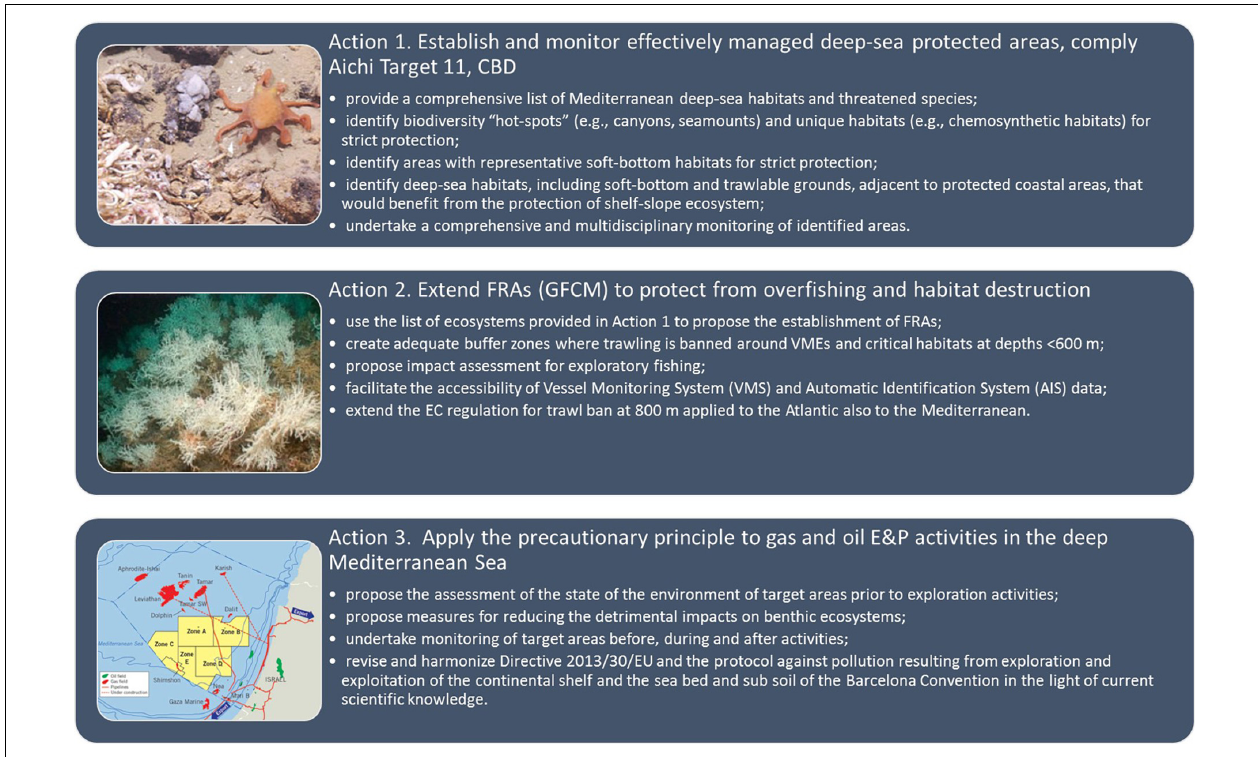
FIGURE 4 | Actions proposed for implementing the protection of ecosystems in the deep Mediterranean Sea and against the two main anthropogenic threats (AT), which are deep-sea fisheries and oil and gas exploration and production